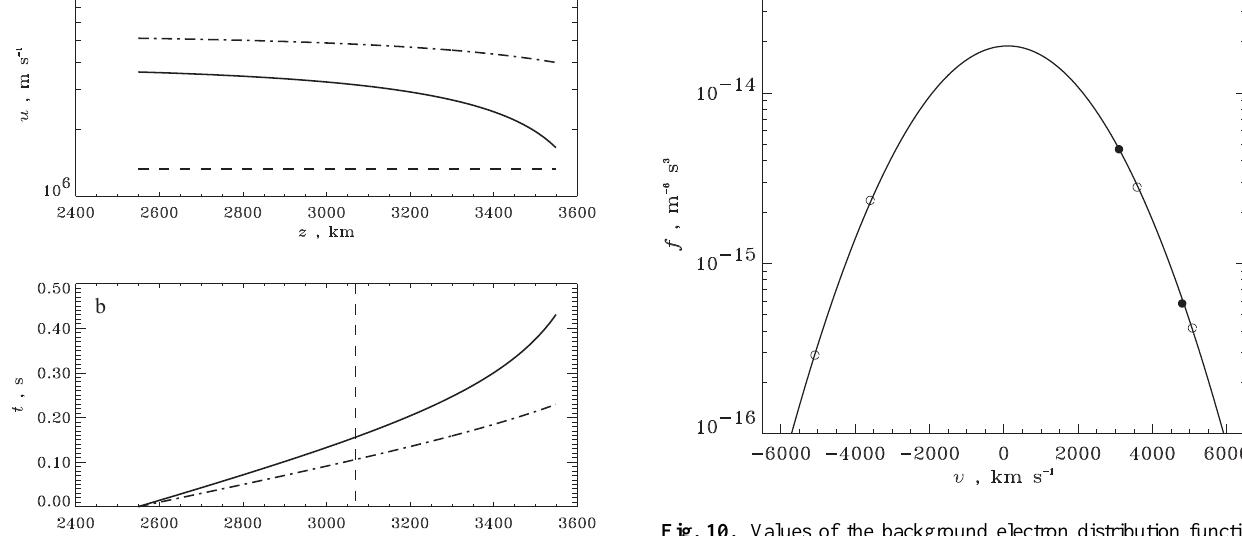
Fig. 10. Values of the background electron distribution function measured by the electrostatic analyser into the two energetic chan- nels with central energies 37 and 74 eV between 20:16:22 and 20:16:23 UT (open circles); together with the reconstructed dis- tribution function of the warm electron population: (i) background population with n = 1 . 6 · 10 6 m − 3 , u o = 106 km s − 1 , T = 18 . 5 eV (solid line); (ii) values of the distribution function near the upper boundary of the acceleration region (filled